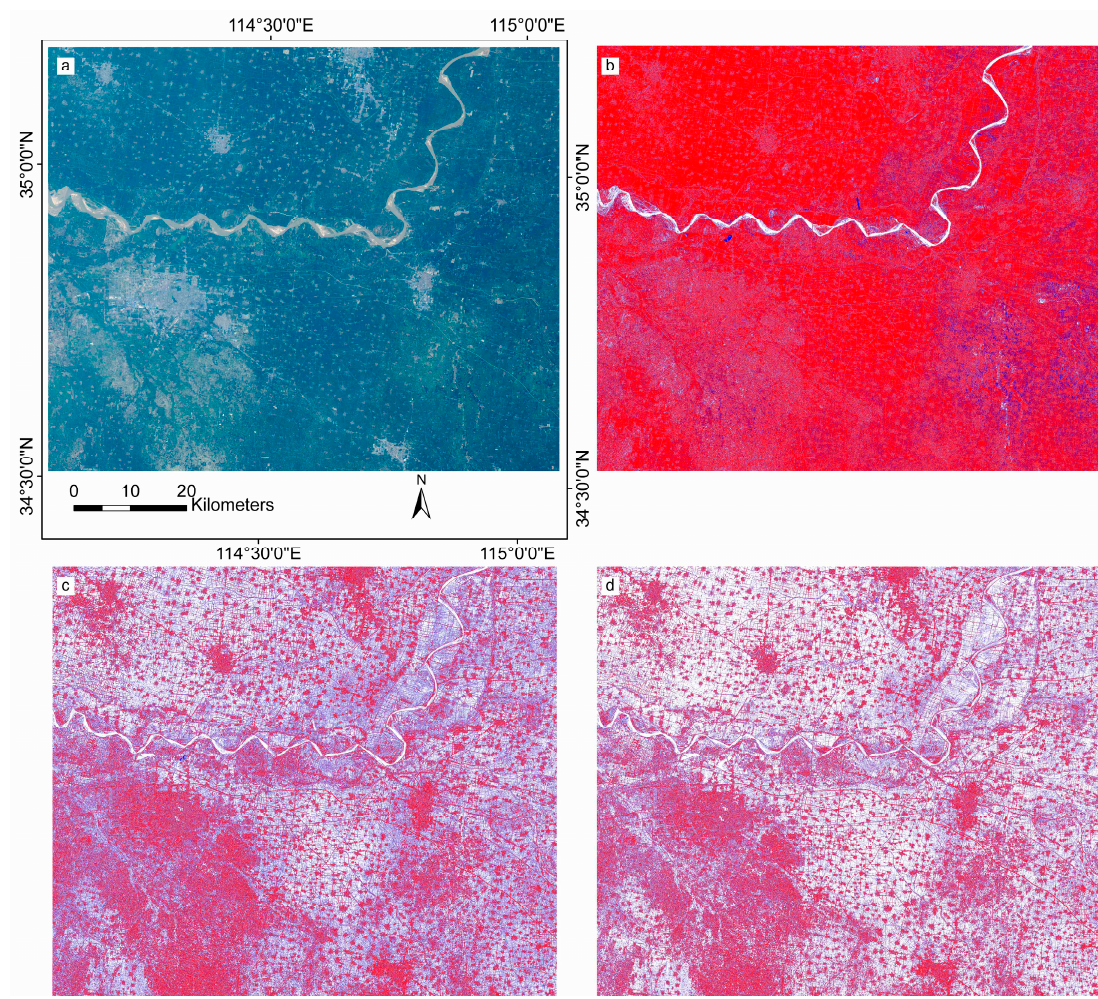
Figure 4. China 2976 × 2520 30 m Landsat 8 TOA red, green, blue TOA reflectance ( a ). Absolute reflectance differences between the 15 m panchromatic band and the 15 m resampled intensity images generated using: the equal spectral weights ( w red = w green = w blue = 1 { 3 ) ( b ); the spectral response function based (SRFB) spectral weights ( w red = 0.4030, w green = 0.5177, w blue = 0.0802) ( c ); and the image specific spectral weights ( w red = 0.4568, w green = 0.5041, w blue = 0.0361) ( d ). Absolute reflectance differences colored as: 0 ≤ white < 0.0035, 0.0035 ≤ blue < 0.0070, and red ≥ 0.0070. The 30 m true color and the 30 m intensity images were cubic convolution resampled to the 15 m panchromatic band grid.